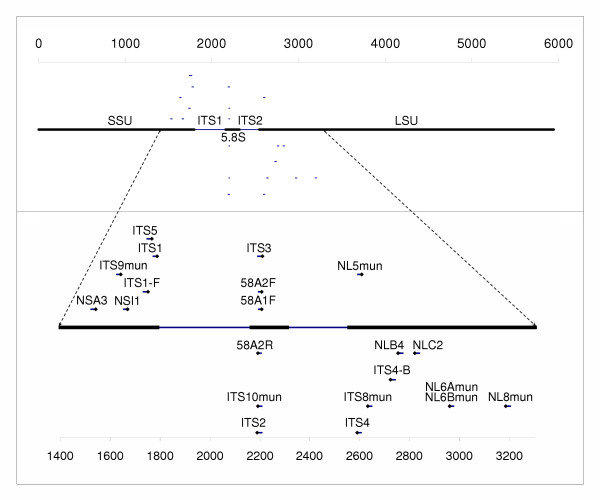
Diagram of primer locations in the ribosomal cassette consisting of SSU, ITS1, 5.8S, ITS2, and LSU rDNA. Primers are positioned above (forward primers) or below (reverse) their sequence positions. ITS1, ITS2, ITS3, and ITS4 from White et al. [5], primers ITS8mun, ITS9mun, ITS10mun, NL5mun, NL6Amun, NL6Bmun, NL8mun from Egger [16], primers ITS1-F, ITS4-B from Gardes and Bruns [6] and the remaining primers (NSA3, NSI1, 58A1F, 58A2F, 58A2R, NLB4, NLC2) from this study. Scale is in base pairs according to the extension of the Gargas and DePriest [23] nomenclature system described in this study.